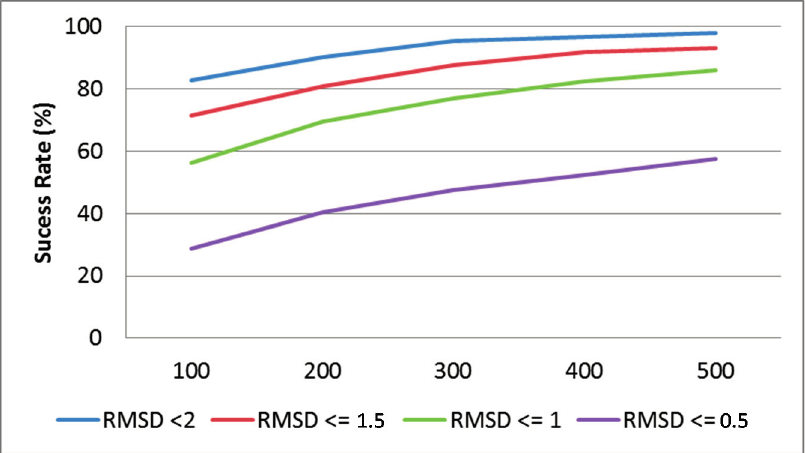
Figure 5. Ability to sample X-ray binding modes (irrespective of their ranking in terms of energy), in function of the number of generations at different RMSD thresholds (Astex Diverse